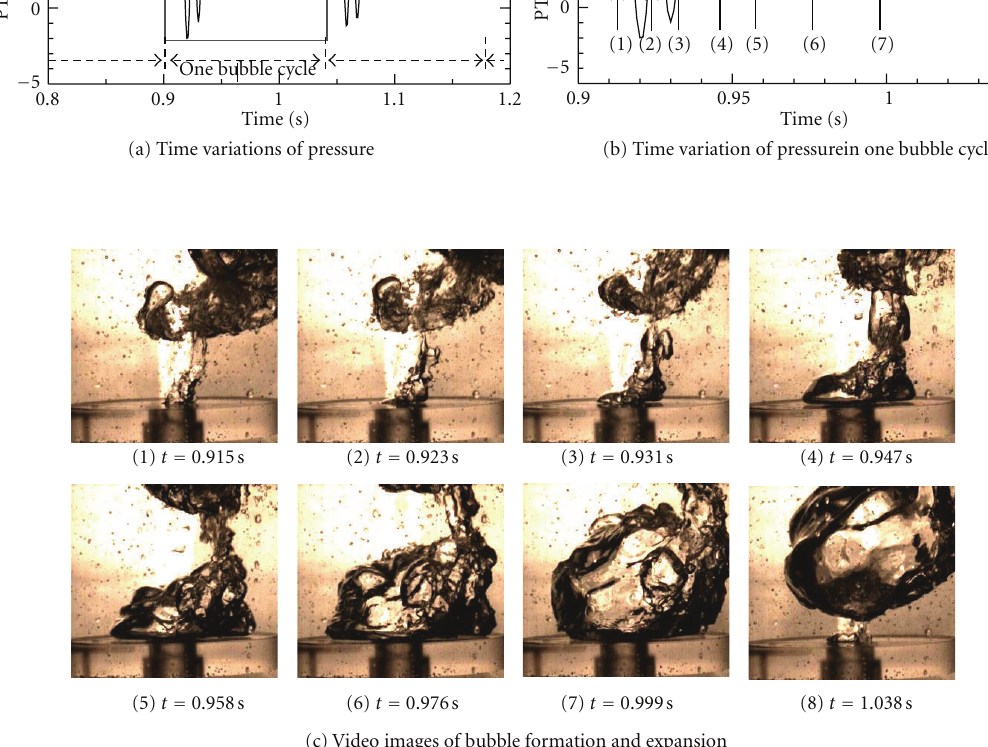
Figure 5: Time variations of pressure at the upper entry of the tube (PT1) and corresponding bubble formation and expansion process (tube = 0 . 68, indicated as (b) in Figure diameter D = 20 mm, j ∗ 0 . 5 g